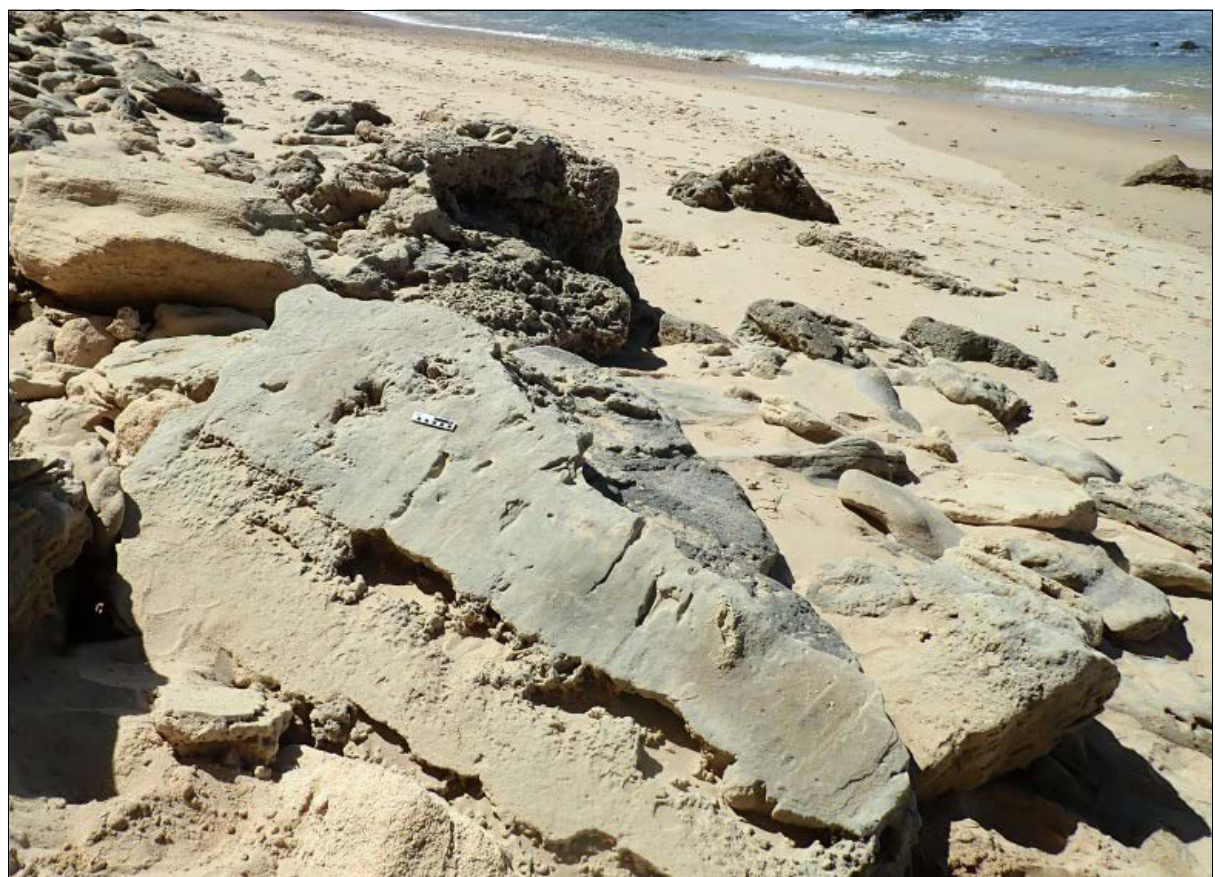
Figure 1: The loose slab containing a newly identified trace fossil-bearing surface lies near the high tide mark; scale bar = 10